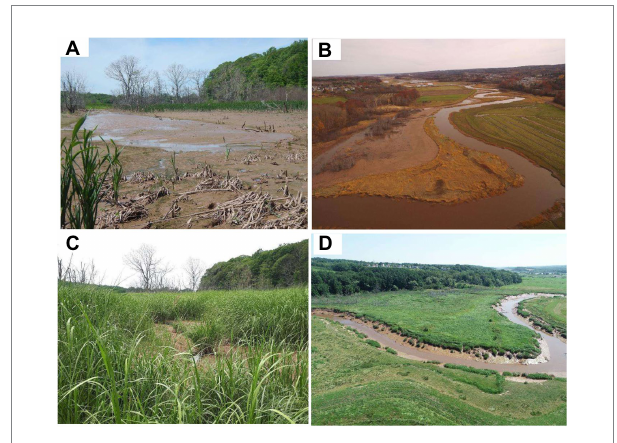
FIGURE 3 Belcher St. site (A) 2018 (Year 1 post); (B) 2018 (Year 1 post) aerial view after dyke realignment; (C) 2021 (Year 4 post); (D) 2021 (Year 4) aerial view.